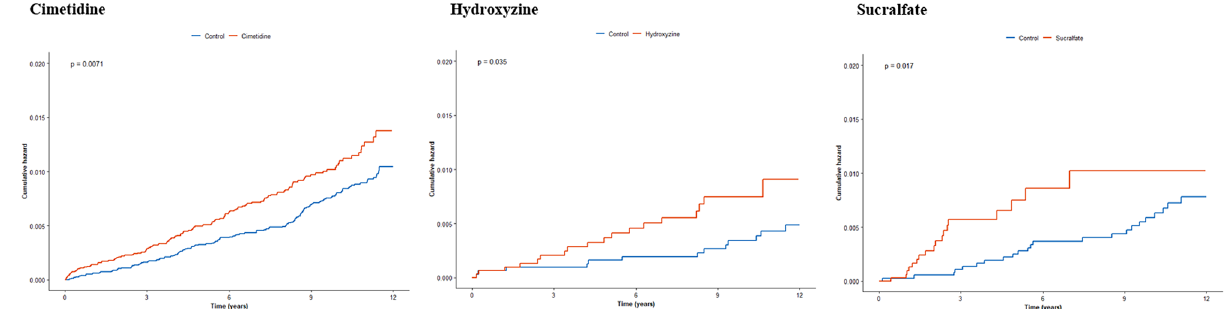
Figure 3. Kaplan–Meier survival curves and log-rank tests for bilateral hearing loss in patients who were prescribed cimetidine, hydroxyzine, and sucralfate.